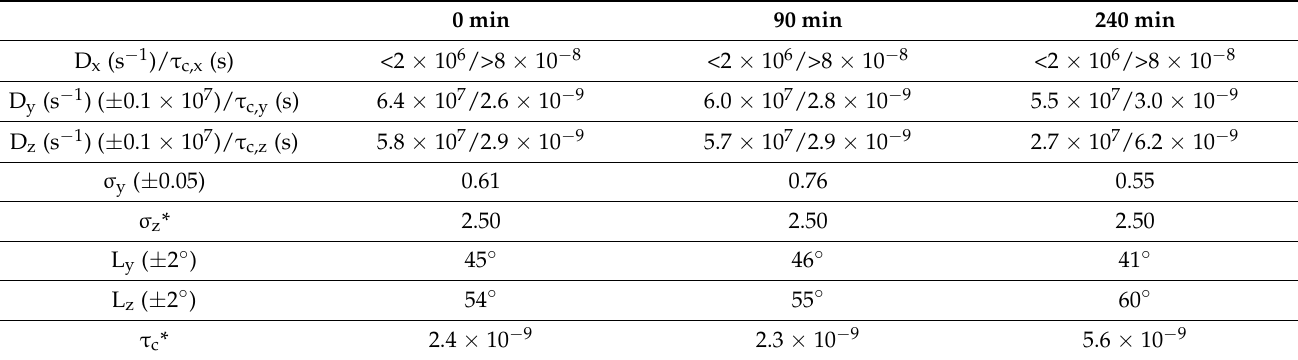
Table 1. Parameters of the rotational mobility of TEMPO radicals in PHB containing 5% TPP at different times of sample annealing. σ is the width of the lognormal distribution of paramagnetic molecules with respect to rotational mobility; L—amplitudes of